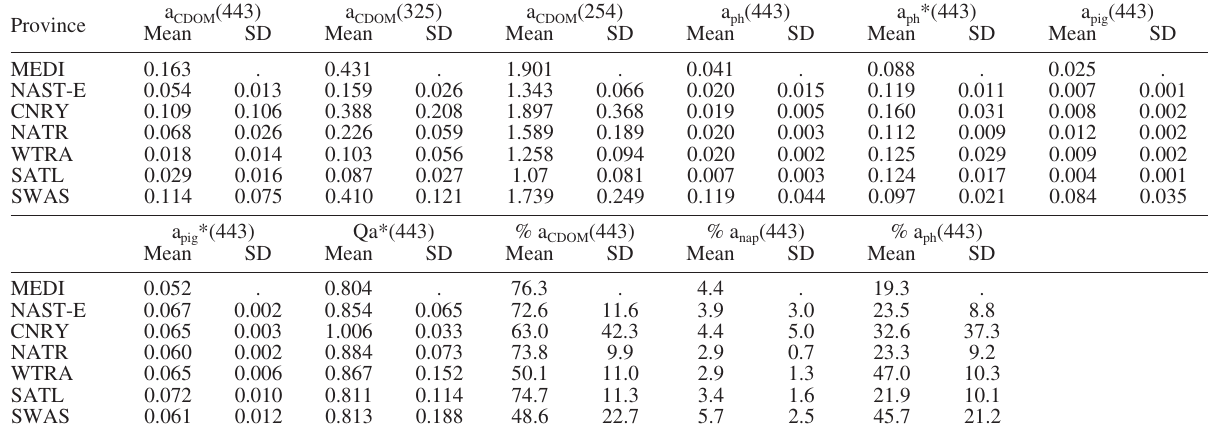
Table 7. – Average (± SD) values of the CDOM absorption at 443 nm [a the percentage contribution to total non-water absorption at 443 nm by CDOM [a phytoplankton [a (443)] for the different provinces. a ph the Chl a _tot-specific values corresponding respectively to a